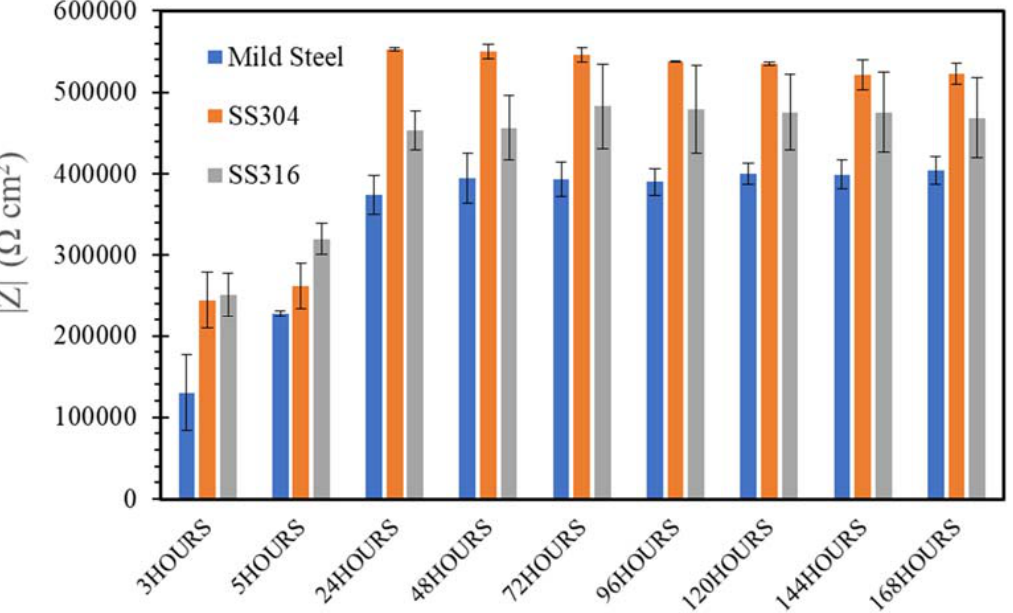
Figure 10. Evolution of impedance |Z| for of mild steel, SS304 and SS316 in NC solution.